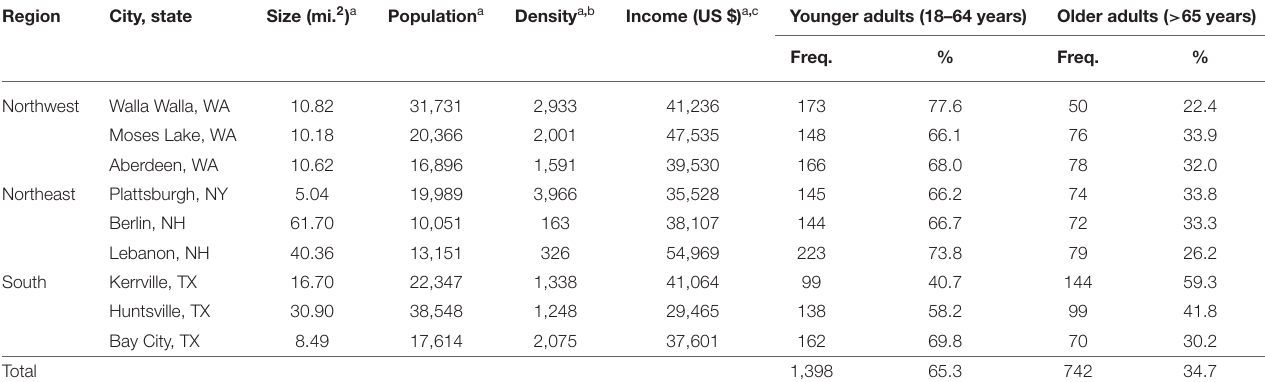
TABLE 1 | Survey respondents by town and by age group. Region City,